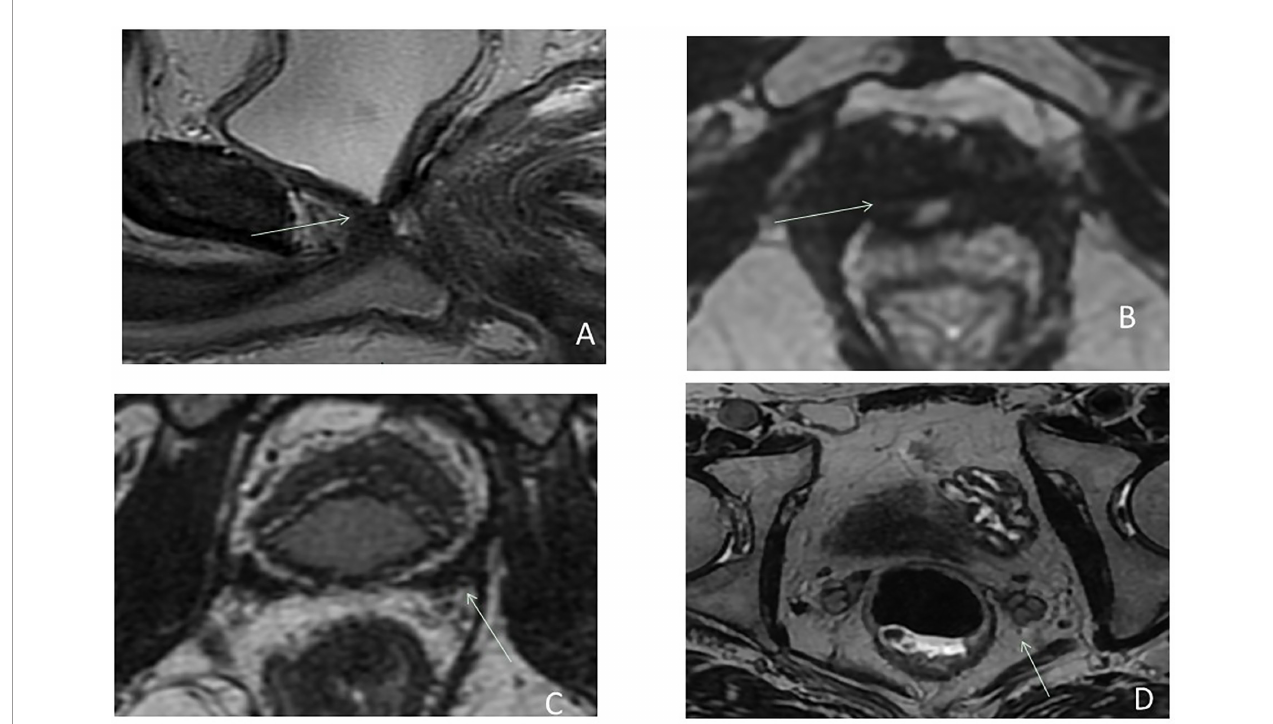
FIGURE 1 | Postsurgical imaging fi ndings after radical prostatectomy on sagittal (A) and axial (B – D) T2-weighted imaging: bladder neck descended into the prostatectomy fossa with a more conical shape (A) ; the VUA anastomosis (arrow) (A, B) visualized as a ring of postoperative fi brosis on low signal intensity inferior to the bladder neck. Seminal vesicles which are supposed to be removed in a classical RP demonstrate a low signal intensity (C) (postoperative fi brosis), but may be retained in part and can be seen in their presurgical locations with their characteristic tubular structure on T2W (D)